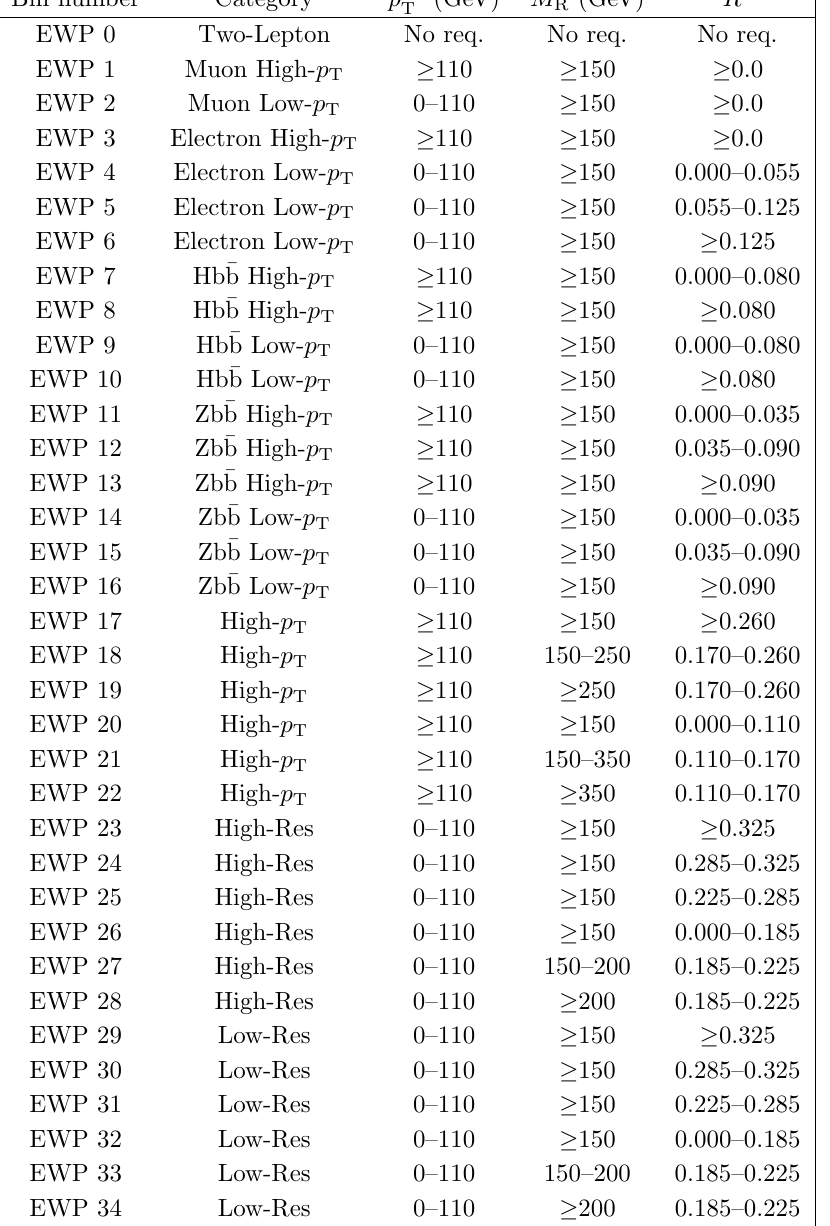
Table 1 . A summary of the search region bins used in the EWP analysis. Events are separated into categories based on the number of leptons, the presence of H ! b (cid:22) b candidates, the p T of the H ! (cid:13)(cid:13) candidate, and the estimated diphoton mass resolution. The High-Res and Low-Res categories are de(cid:12)ned by the estimated diphoton resolution mass (cid:27) m =m being smaller or larger than 0 : 85%, respectively. For the Two-Lepton category, \No req." means that no requirements are placed on the given observables.